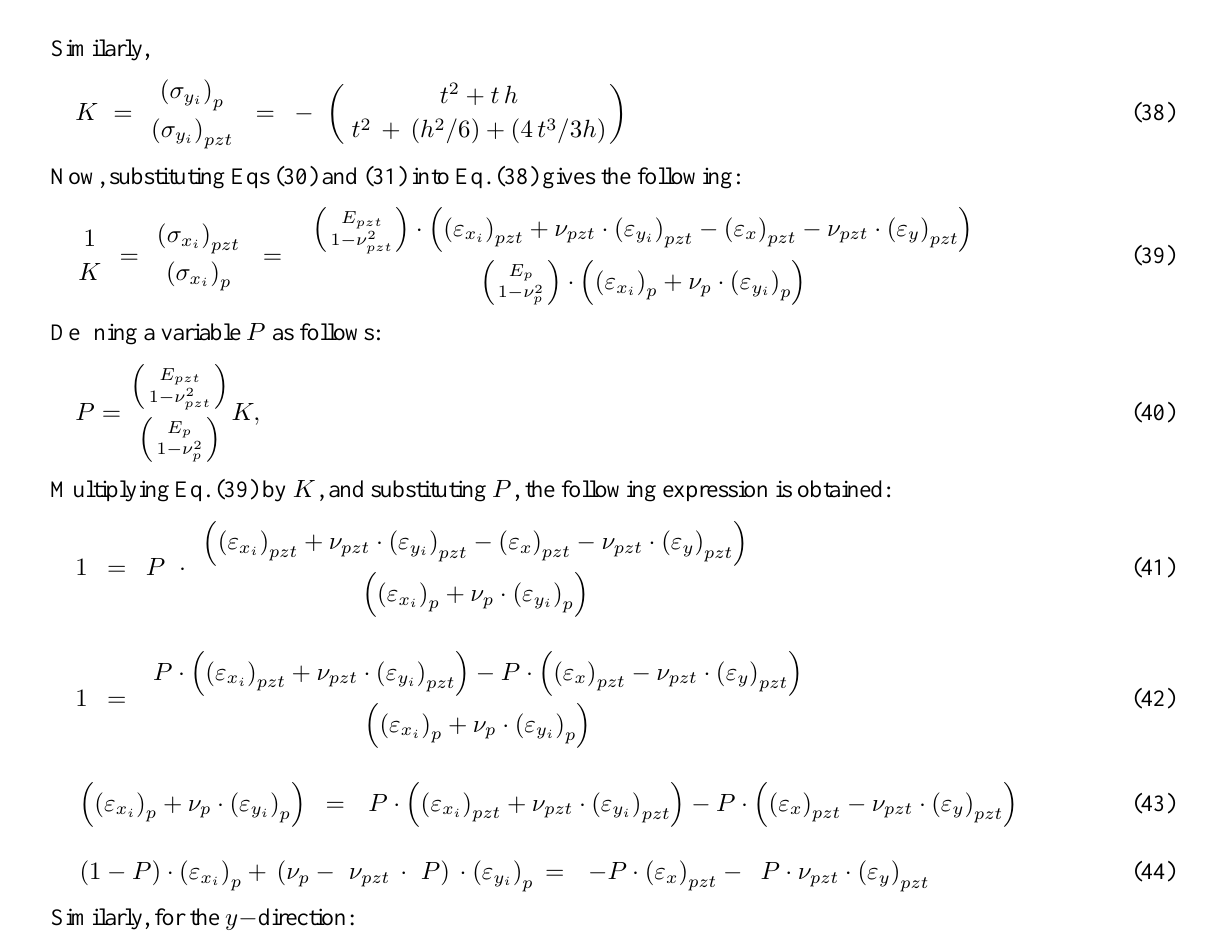
Fig. 18. Test response of the actual Cross Array with all outputs, center